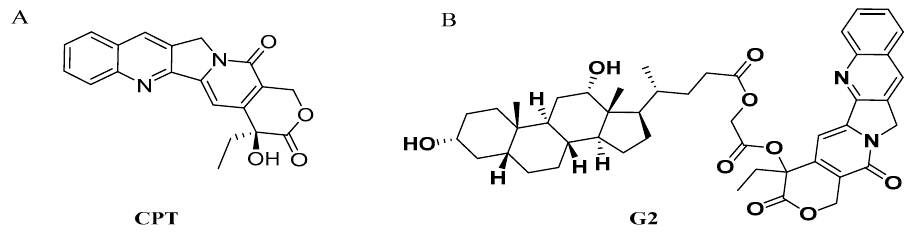
Figure 1. Chemical structures of CPT ( A ) and G2 ( B ).